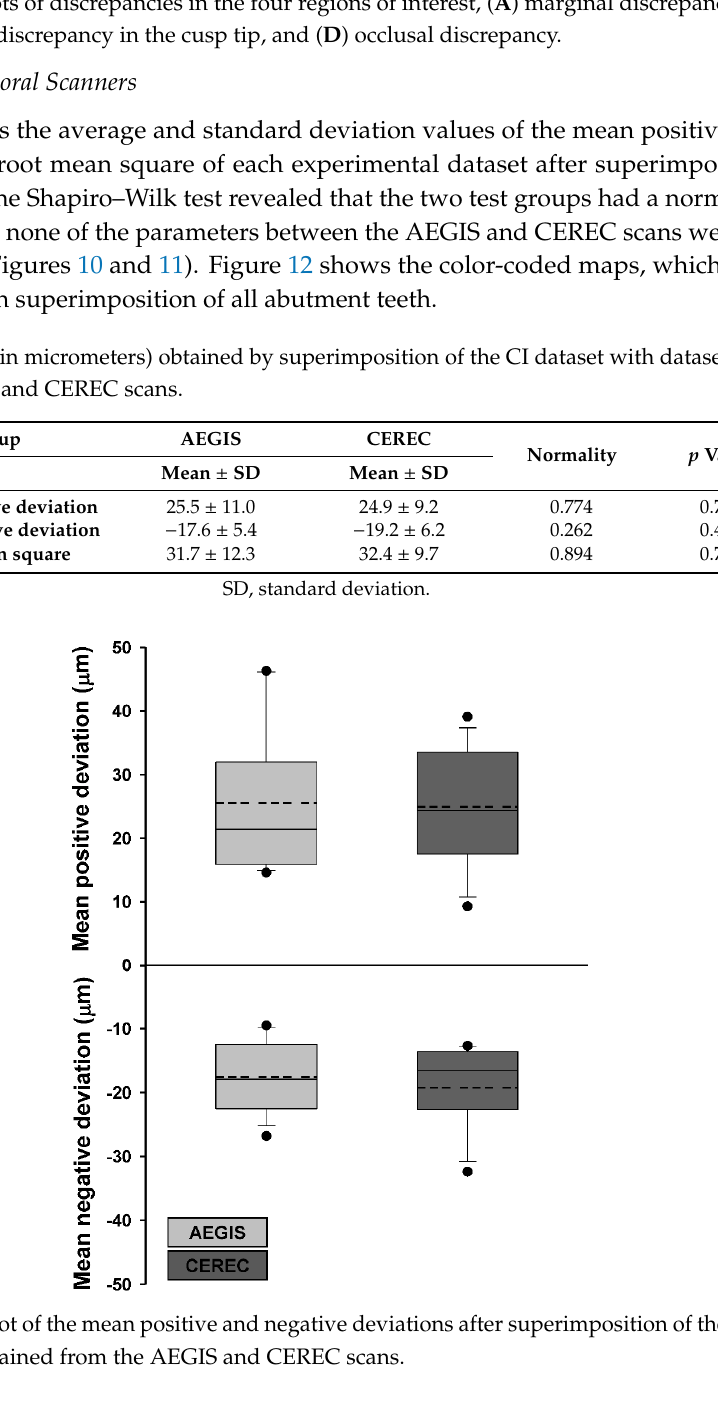
. Figure 11. Box plot of root mean square between the CI dataset and datasets obtained using the AEGIS and CEREC scans.